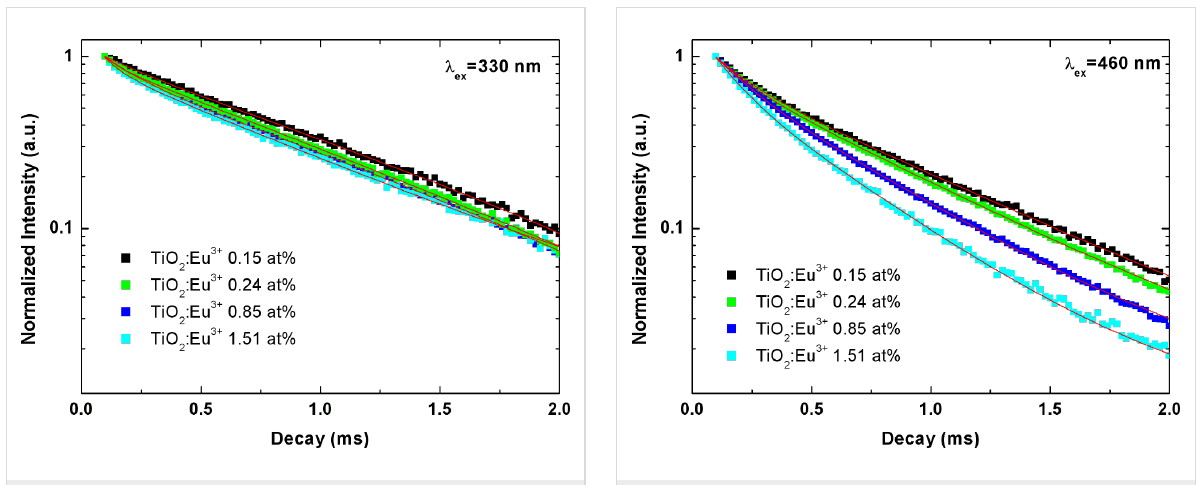
Different observations are made for excitation below the band gap of the TiO 2 . Figure 6 shows the decay curves measured for excitation with 460 nm wavelength. The curves clearly deviate from a single exponential decay, and the decay behavior clearly depends on the Eu 3+ concentration. The general trend observed is that the decay gets faster with increasing Eu 3+ content. The lifetime decreases continuously from 0.69 ms for 0.15 atom %